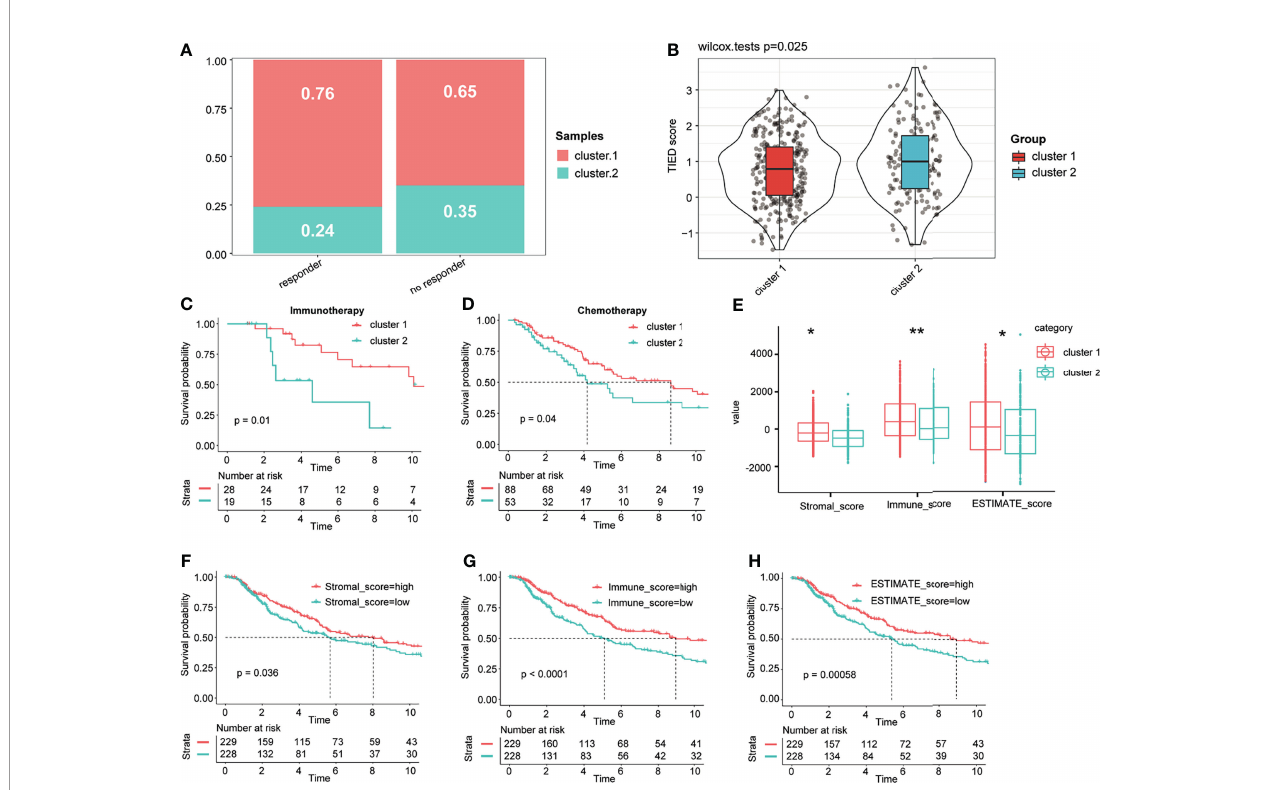
FIGURE 4 | Different responses to treatment between the two groups and immune score landscape in the cohort. Based on the results of TIDE analysis, we compared the ef fi cacy of immune checkpoint block and TIDE score in patients with cluster 1 and cluster 2 (A, B) . The KM analysis of the patients who had received immunotherapy and chemotherapy between the two clusters (C, D) . Different immune and stromal scores between the two groups (E) . Kaplan – Meier analysis of the CM data in the TCGA cohorts showed that OS was signi fi cantly shorter in the low-stromal, immune, and ESTIMATE score groups (F – H) . * and ** represent P < 0.05, P <